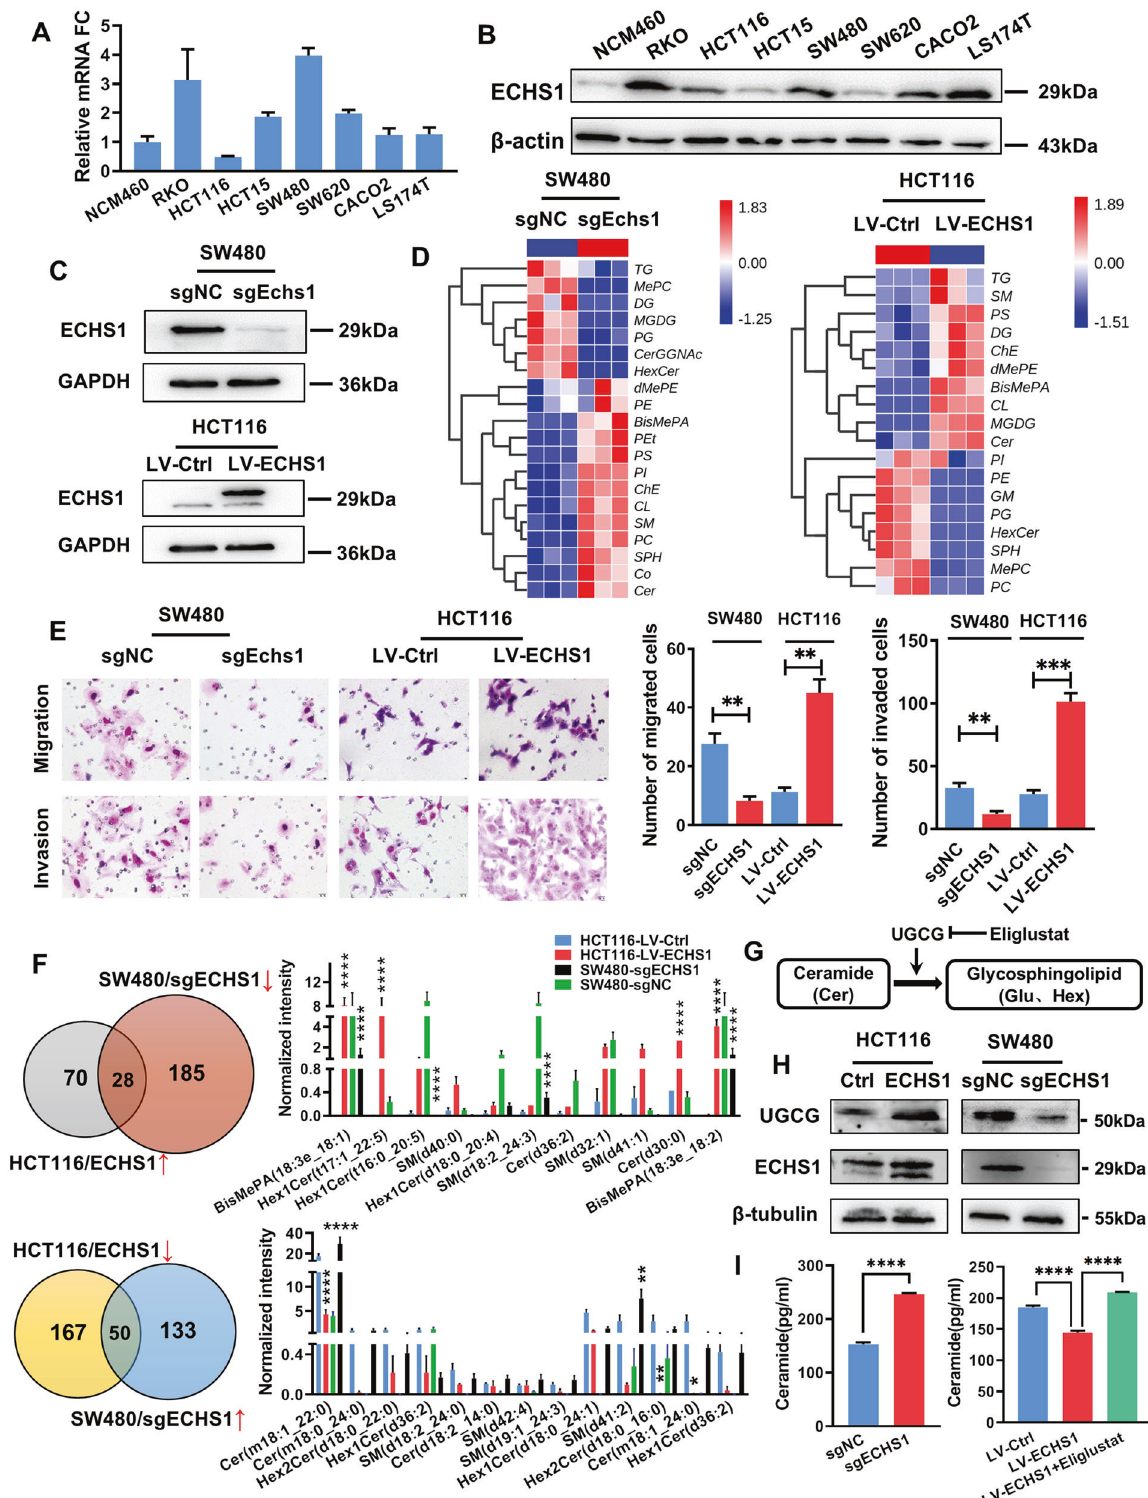
ECHS1 on CRC cell proliferation (0.1 ± 0.05 g vs. 0.4 ± 0.3 g, P < 0.01; Fig. 5D), while knocking out ECHS1 dramatically inhibited the growth of subcutaneous tumors (0.2 ± 0.05 g vs. 0.08 ± 0.05 g, P < 0.01; Fig. 5E). We observed that endogenous overexpression of ECHS1 could reduce Oxaliplatin-induced apoptosis of CRC cells,